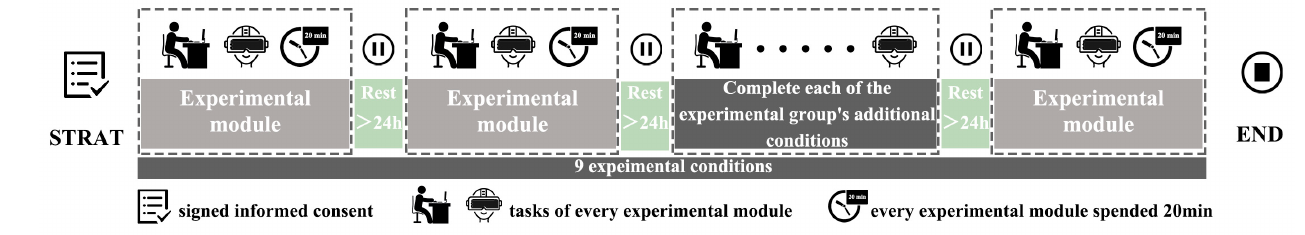
Figure 5. Basic experimental process.